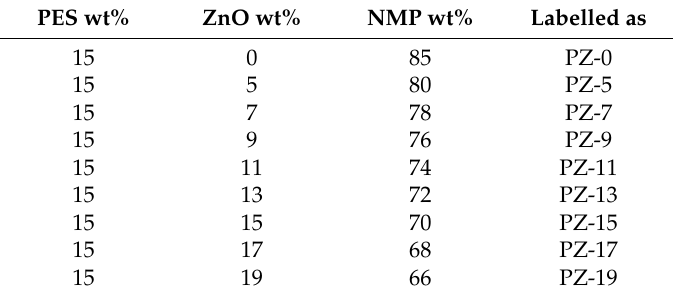
Table 5. The compositions of casting solution of polyethersulfone (PES)/ZnO film photocatalysts. NMP = N